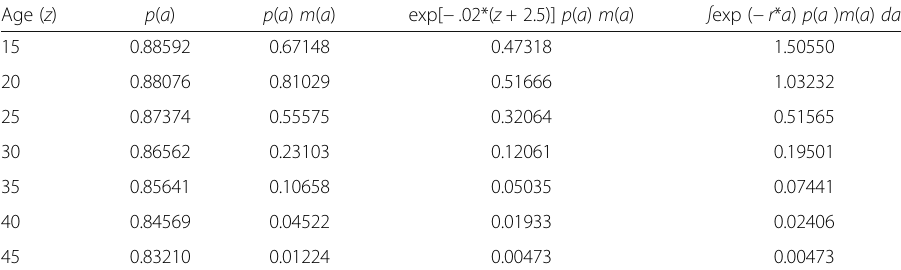
Table 1 Values of R 0 , μ , r , and net maternity function p ( a ) m ( a ) along with the computation of exp ( − r * a ) p ( a ) m ( a ) for predicting the proportion of contraceptive users to attain the rate of growth r * = 0.020 from r =